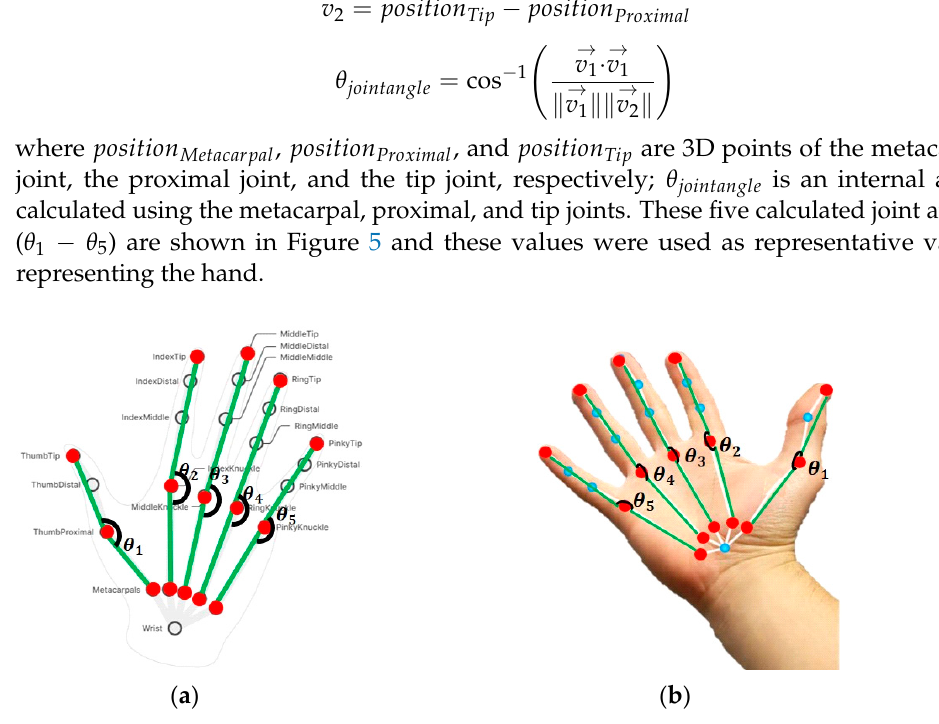
Figure 5. Joint angles ( θ 1 − θ 5 ) for each finger used as representative values: ( a ) back of the right hand; ( b ) palm of the right hand.